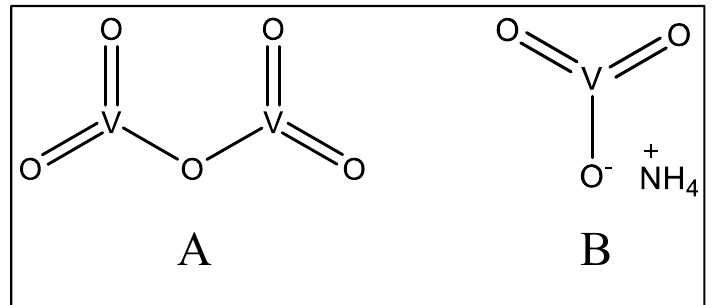
Figure 7. Structures of some vanadate compounds.